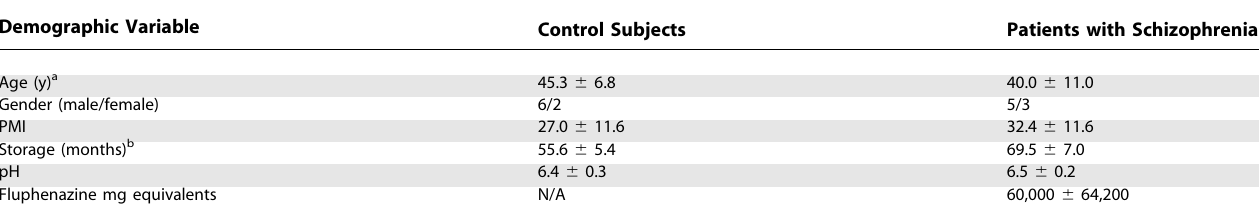
Table 4. Demographic Details of Subjects Investigated for VGF Expression by Western Blot Analysis of Post-Mortem Brain